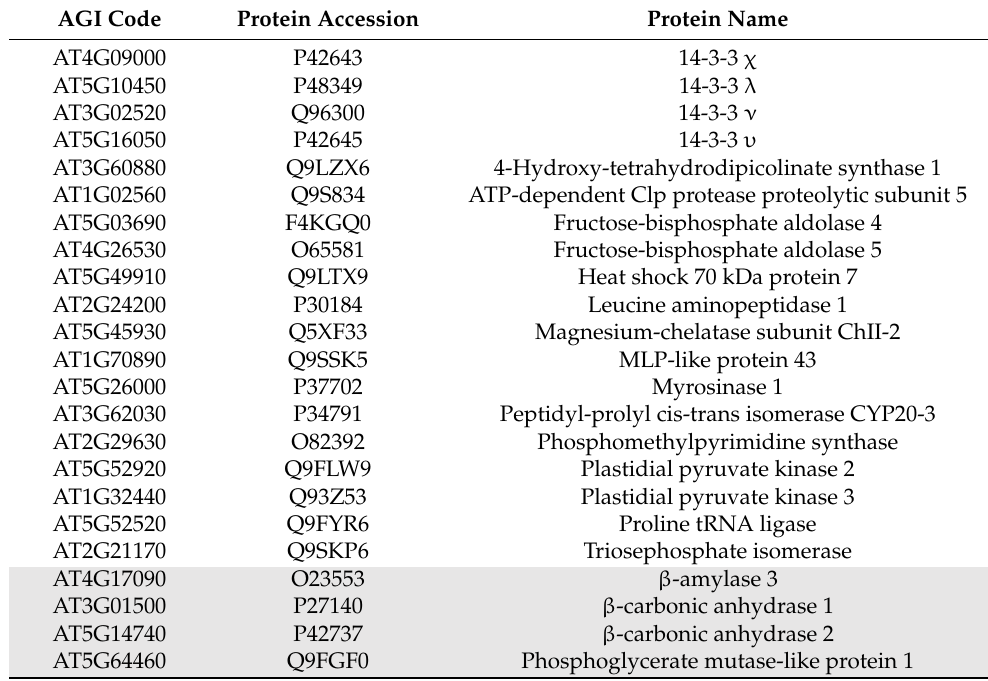
Table 2. Chloroplast localized interaction partners of PRX-IIE WT. Listed are the proteins identified from elution with DTT and imidazole (grey background), with AGI code and uniport accession